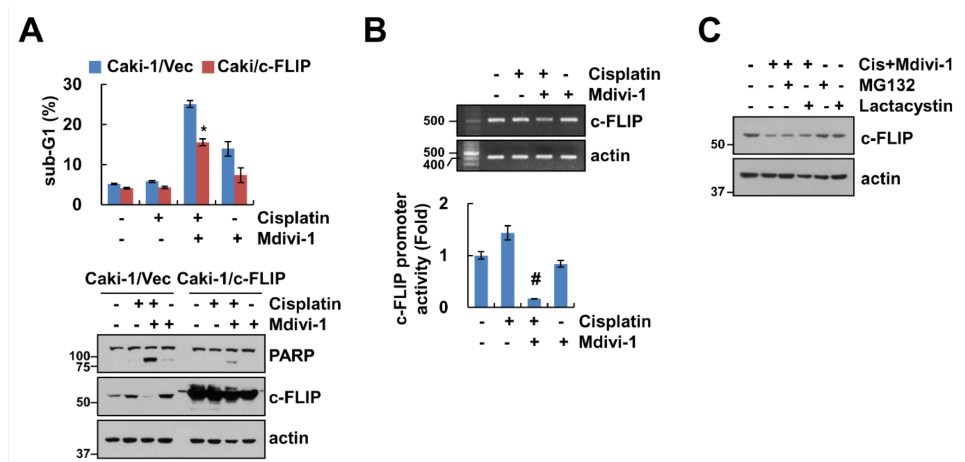
Figure 4. Combined treatment of mdivi-1 plus cisplatin inhibits c-FLIP expression at the transcription level. ( A ) Vector cells and c-FLIP-overexpressing cells were treated with 10 µ M mdivi-1 alone, 20 µ M cisplatin alone, or mdivi-1 plus cisplatin for 24 h. ( B ) Caki-1 cells were treated with 10 µ M mdivi-1 alone, 20 µ M cisplatin alone, or mdivi-1 plus cisplatin for 24 h. The mRNA expression and promoter activity were detected using reverse transcription polymerase chain reaction (RT-PCR) and luciferase activity kits, respectively. ( C ) Caki-1 cells were treated with 10 µ M mdivi-1 plus 20 µ M cisplatin in the presence or absence of 0.5 µ M MG132 or 2.5 µ M lactacystin for 24 h. The sub-G1 population and protein expression were detected by flow cytometry ( A ) and Western blotting ( A , C ), respectively. The values in graph ( A , B ) represent the mean ± SEM of three independent experiments. * p < 0.01 compared to the mdivi-1 plus cisplatin in Caki-1 / Vec. # p < 0.01 compared to the